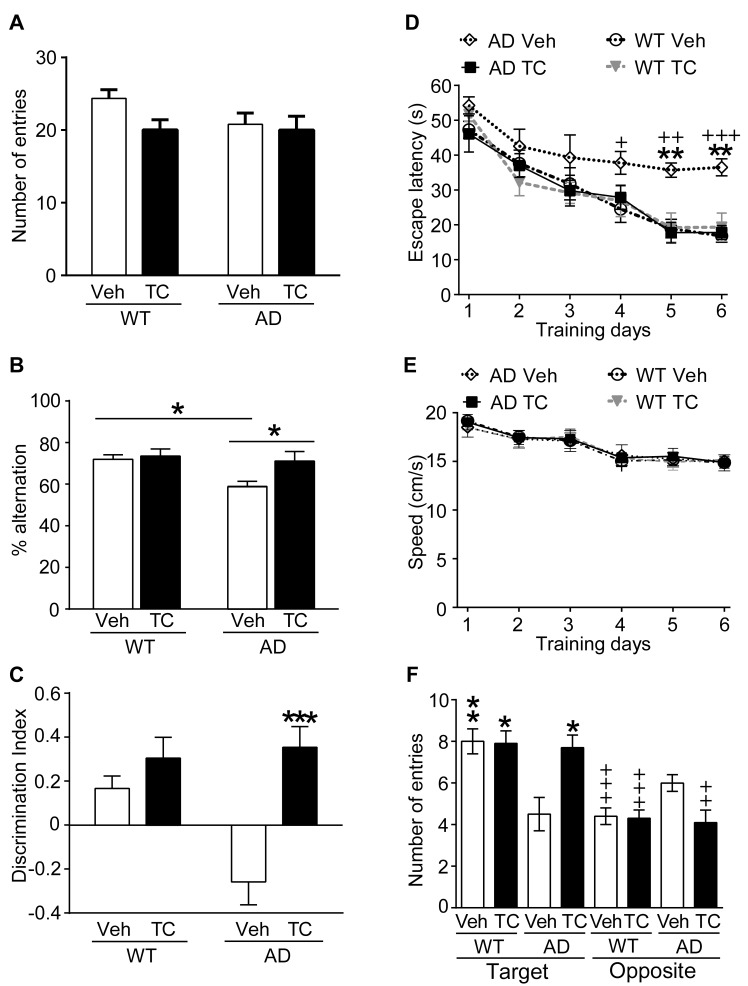
TC-2153 improves cognitive deficits in 3xTg-AD mice.WT and 3xTg-AD mice (male, 6 mo old) were treated with vehicle or TC-2153 (10 mg/kg, i.p.) and tested in the Y-maze, NOR, and MWM tasks. (A and B) Y-maze, number of arm entries and percentage spontaneous alternations were calculated (*p<0.05, paired t test, AD-TC versus AD-Veh) (WT, n = 20/group; AD, n = 11/group). (C) NOR, the DI of each group was calculated (***p<0.001, AD-TC versus AD-Veh) (WT, n = 9/group; AD, n = 16/group). (D) MWM, the 3xTg-AD mice injected with vehicle (n = 6) showed longer escape latency before finding the hidden platform (3 trials/day; 60 s; 30 m intertrial interval) when compared to AD mice treated with TC-2153 (n = 7) or WT mice injected with vehicle (n = 12) or TC-2153 (n = 13) (three-way ANOVA). * and + represents a statistical significant variation between AD-Veh mice and AD-TC or WT-Veh, respectively. (E) Swim speed at each training day was not significantly different between groups (three-way ANOVA). (F) Number of entries in a circular zone positioned around the previous platform location and in the opposite quadrants. * represents a statistical significant variation between AD-TC mice and other groups for the target quadrant. + indicates a difference for the target and opposite quadrant within each group. Data are mean ± s.e.m. *,+
p<0.05; **,++
p<0.01; ***,+++
p<0.01.